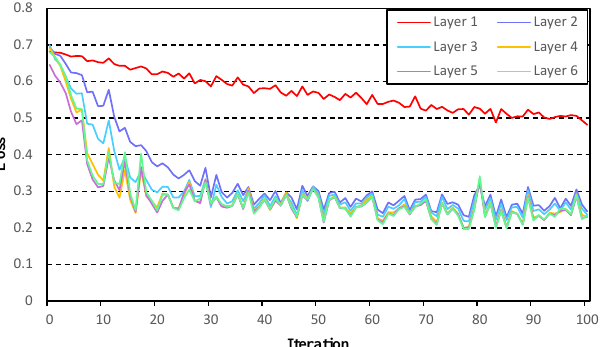
Figure 13. Training loss of each layer of RLC-GNN-6 on Amazon dataset. We note that training loss of later layer is lower, which means that the later layers can make inferences with higher confidence. Table 2. Performance of RLC-GNN-27 and various GNNs on Yelp and Amazon datasets. Yelp Model Recall AUC